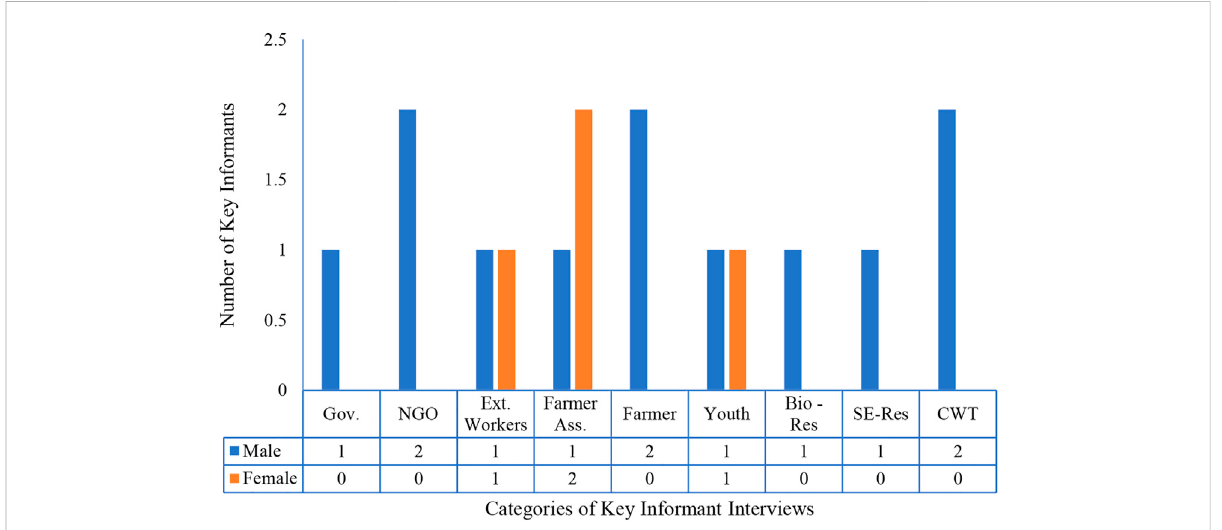
FIGURE 2 Composition of the key informants. Gov. refers to representative of government organization, NGO — non-governmental organization, Ext. Workers — extension/community development workers, farmer refers to knowledgeable farmers, Bio — Res and SE-Res refers to biophysical and socio-economic researchers, respectively, CWT — representative of community watershed team.